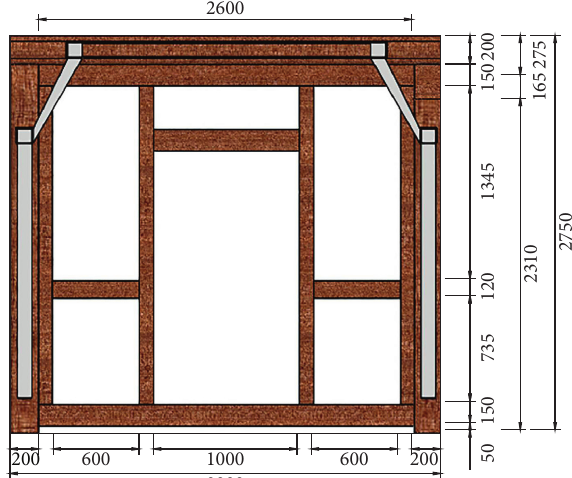
Figure 2: Size of specimen A-2.